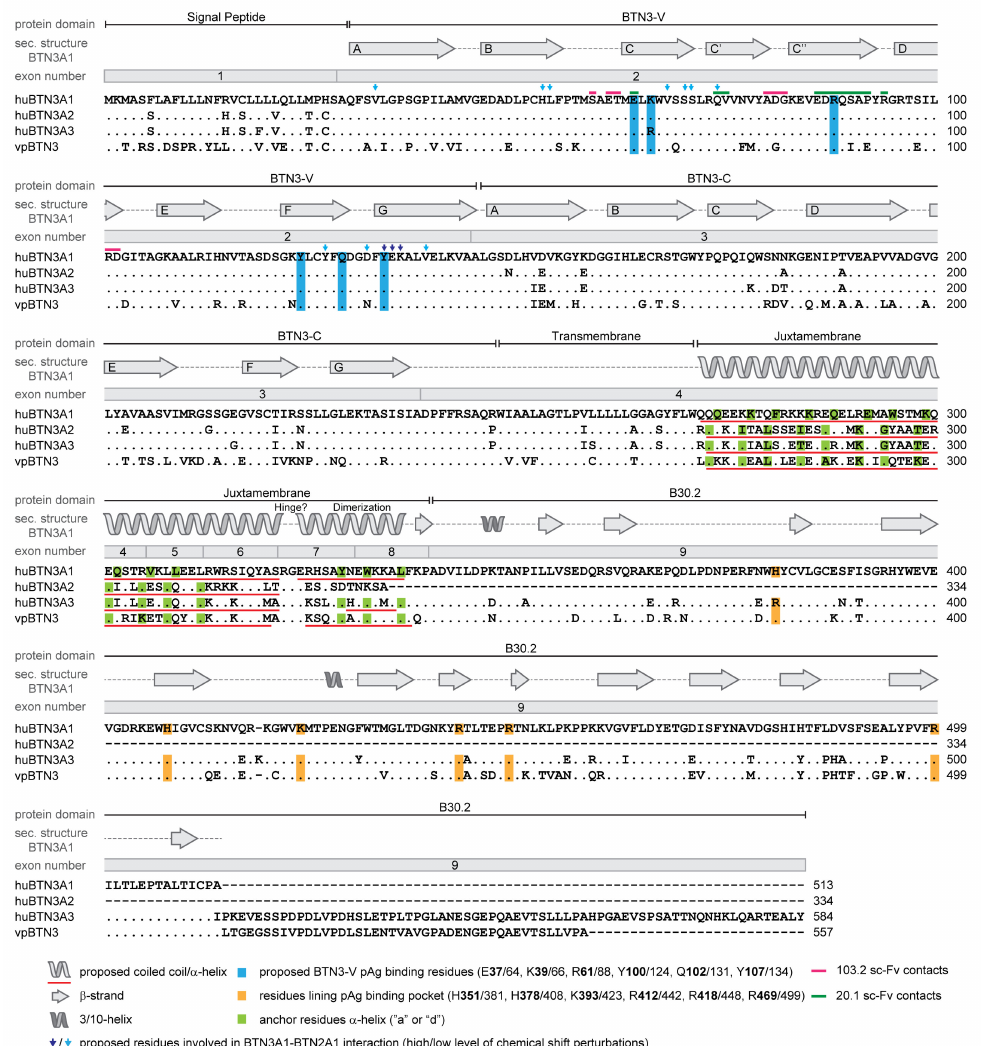
Figure 3. Sequence comparison of human and alpaca butyrophilin (BTN) 3 isoforms. Protein sequence alignment of human BTN3A isoforms and alpaca BTN3 (vpBTN3) (Clustal Omega and BioEdit). Identical amino acids (dots), gaps (dashes), and numbers (right side) are indicated. Amino acid numbers include the signal peptide and are written in standard letters. For amino acid numbers used in the main text, the leader peptide was left out. They are given in bold. The domains of BTN3 (protein domain) and corresponding exons (exon number) are shown according to human BTN3A1 [57,64,65]. Some features of the secondary structure of BTN3A1 are visualized (according to [57,65] and the Protein Data Base BTN3A1 B30.2 protein structure 5HM7). Predicted coiled-coil structures in the juxtamembrane domain (JM) of all BTN3s are shown (red) together with predicted anchor residues (light green) as proposed by Wang et al. [65]. Proposed PAg-binding residues in the BTN3A1 V domain (BTN3-V) are highlighted in blue [66] and residues lining the PAg binding pocket of B30.2 are shown in orange [67]. Contact regions of sc-Fv 103.2 (pink line) and 20.1 (dark green line) in the BTN3A1 V domain are indicated [57]. Blue arrows indicate the residues undergoing chemical shift perturbations (CSP) in a nuclear magnetic resonance (NMR) study of the BTN3A1–BTN2A1 interaction [68]. The residues with the most pronounced CSPs are marked with dark blue arrows, whereas lower CSPs are indicated by light blue